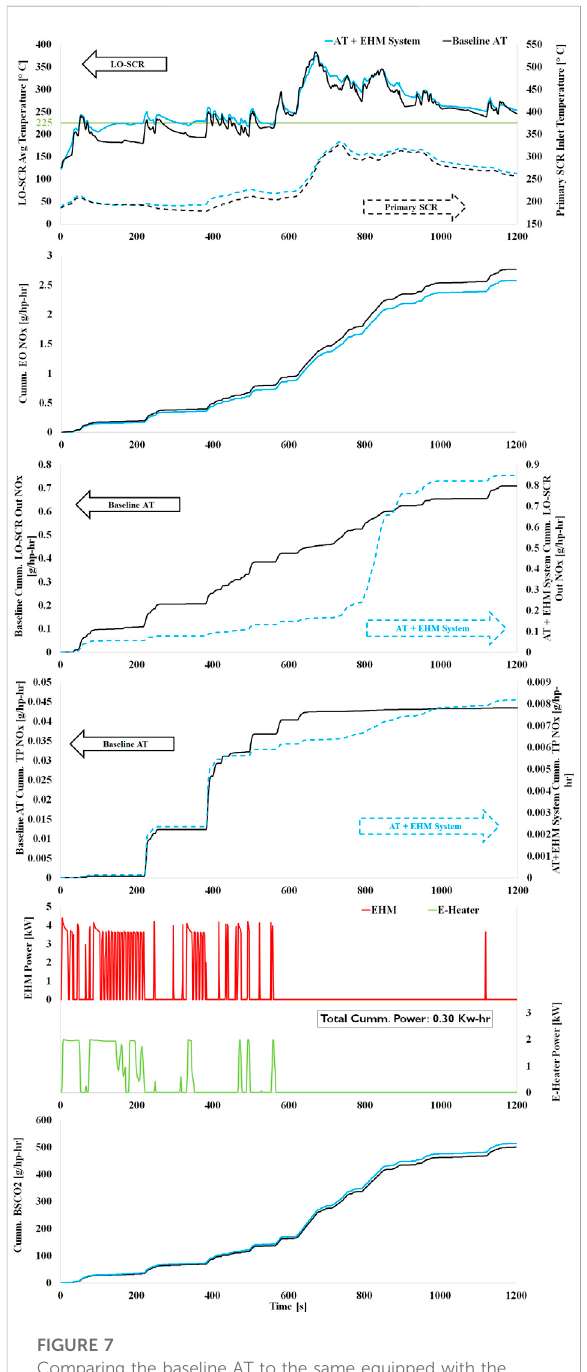
FIGURE 7 Comparing the baseline AT to the same equipped with the EHM system on a hot FTP cycle for the LO-SCR average temperature, primary SCR inlet temperature, EO NO x ,LO-SCRout NO x , TP NO x , heater power consumption, and BSCO 2 .